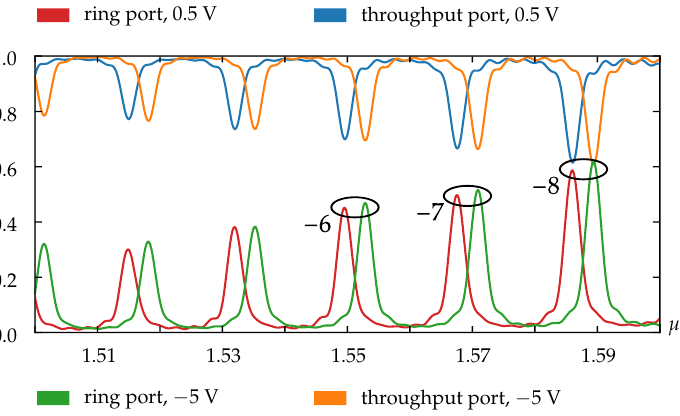
Figure 4. Normalized transmission spectra for the ring with radius 5.5